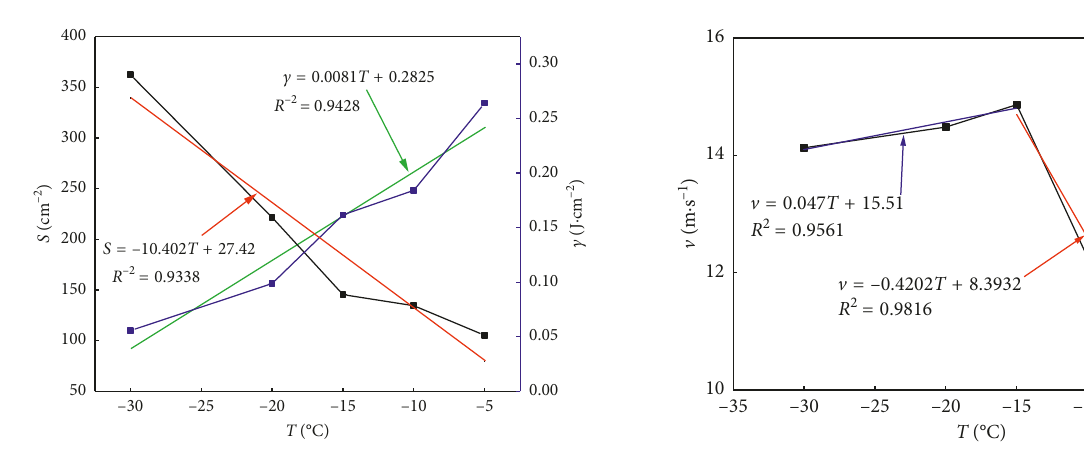
Figure 10: Effect of freeze-thaw cycle on surface energy of